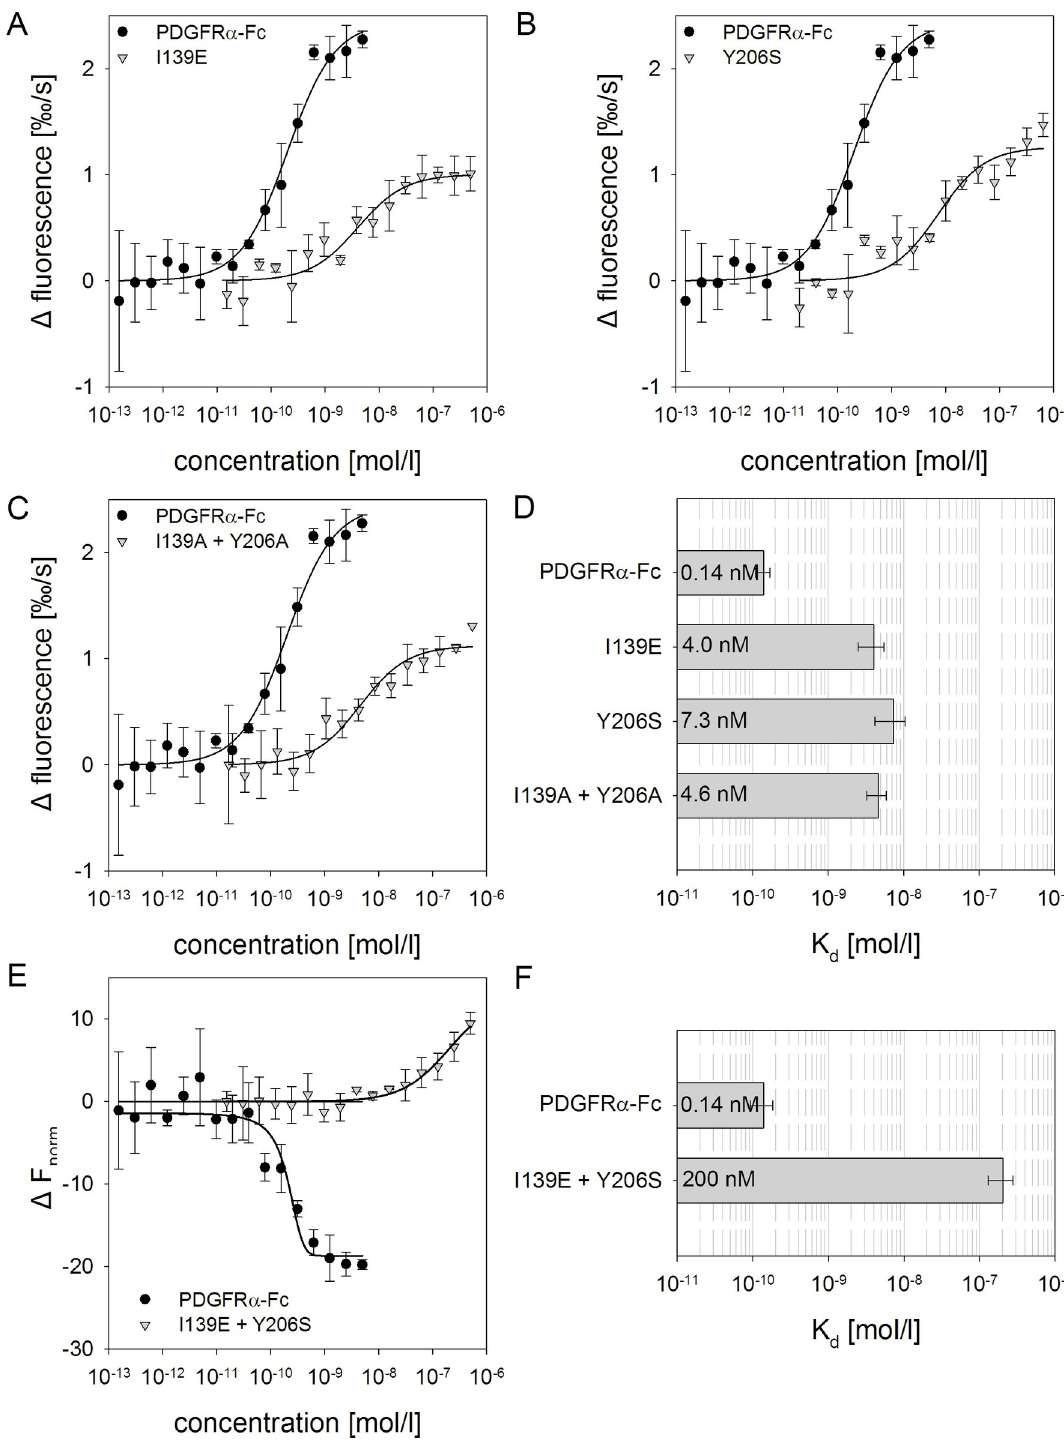
Fig 7. Mutations in PDGFR α -Fc reduce binding affinity for PDGF-BB. Quantification of biochemical binding affinity of PDGFR α - Fc variants for PDGF-BB was assessed by microscale thermophoresis. All experiments were performed with 0.1 nmol/l (2.5 ng/ml) fluorescently labelled (NT-647) PDGF-BB. A to C: Various concentrations of PDGFR α -Fc wildtype and I139E ( A ), Y206S ( B ) or I139A + Y206A ( C ) were mixed with PDGF-BB. Dose dependent fluorescence quenching rates from 3 measurements were used to generate binding curves. The respective curves were fitted to a one site binding model to determine K d values, graphed in D . Error bars indicate